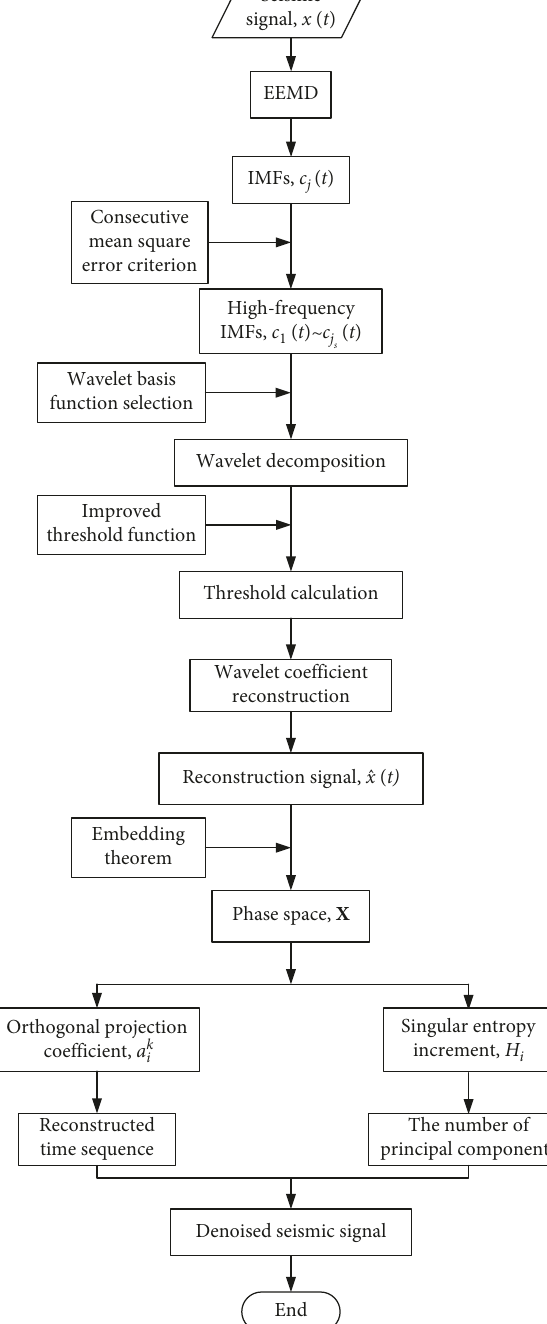
Figure 1: Flowchart of the EEMD-Wavelet-SSA denoising